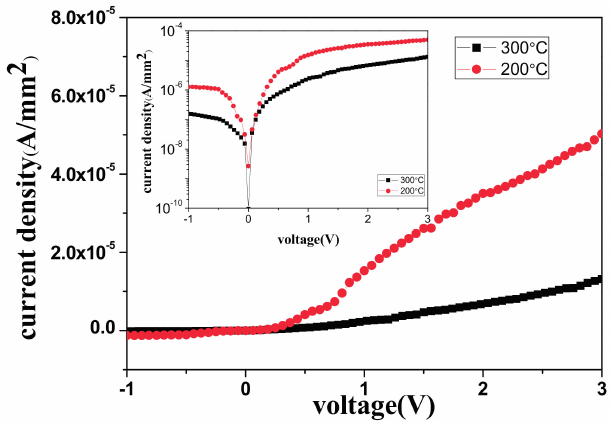
Figure 4. The J–V figure of 200 ◦ C/300 ◦ C AZO thin film deposited on Si substrate demonstrated a lower turn on voltage on 200 ◦ C AZO/Si Schottky barrier diodes (SBDs).